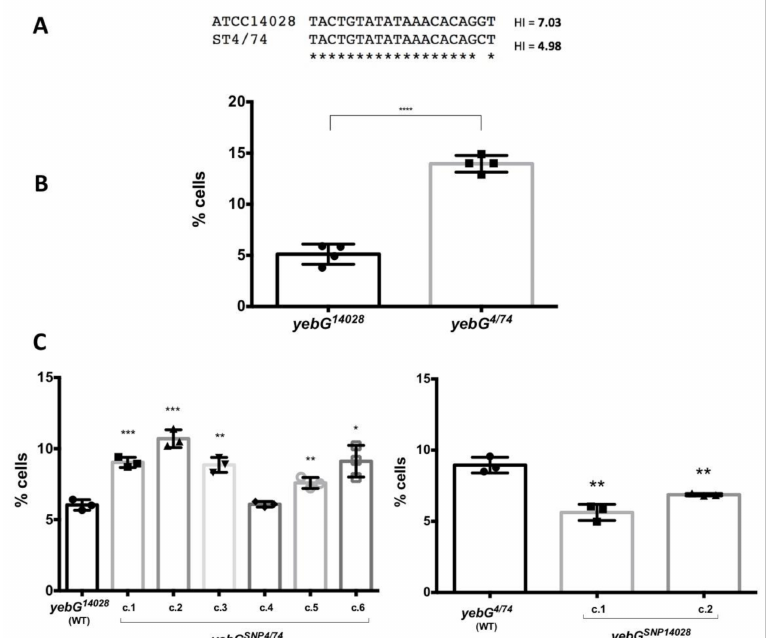
Figure 6. Comparison of YebG ON subpopulation sizes between S. Typhimurium strains ATCC 14028 and ST4/74. ( A ). Single-nucleotide polymorphism in the yebG SOS boxes of ATCC 14028 and ST4/74. HI values are indicated. ( B ). Percentages of YebG ON cells in ATCC 14028 and 4/74. ( C ). Percentages of YebG ON cells in in ATCC 14028 and 4/74 derivatives whose SOS boxes have been swapped. Statistically significant differences are indicated ( p -value; * p < 0.05, ** p < 0.01, *** p < 0.001, **** p <